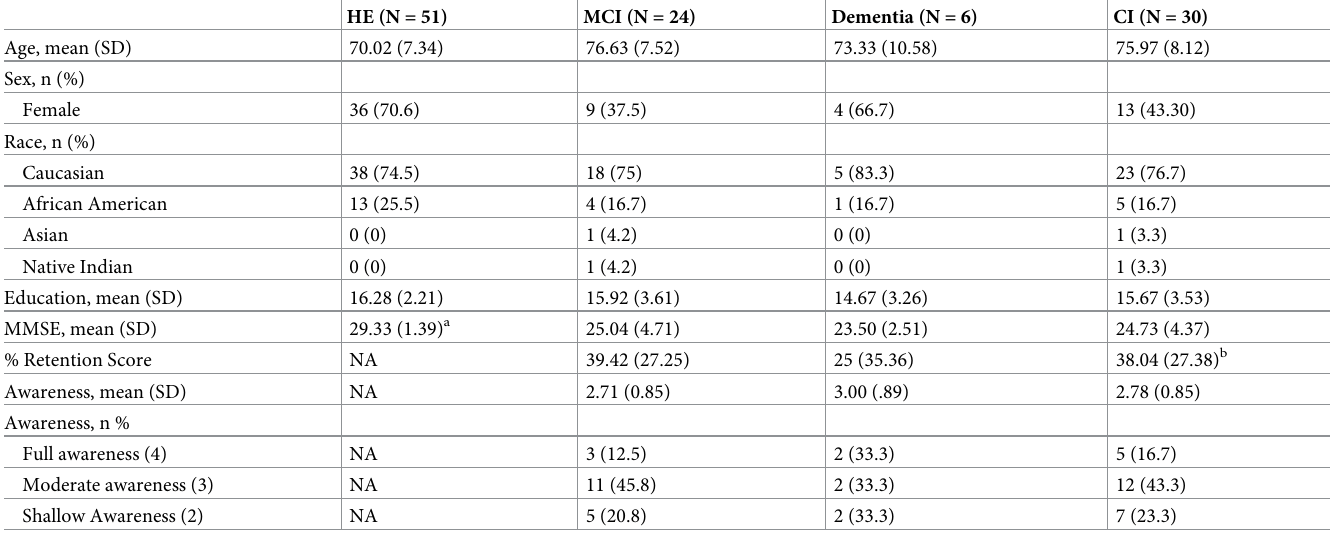
Table 2. Descriptive information about demographics for all